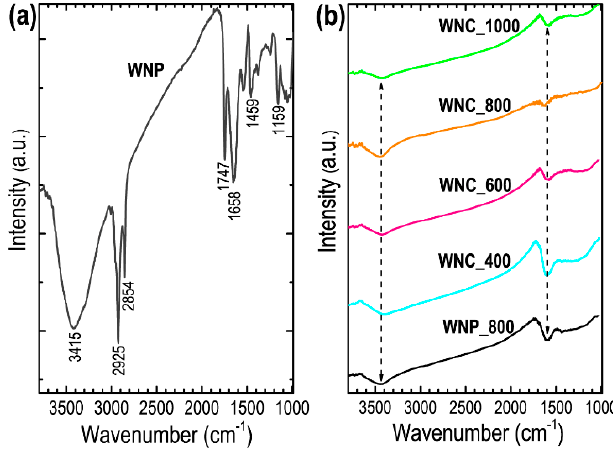
Figure 3. ( a ) FTIR spectrum of Washnut seed powder (WNP) before activation, and ( b ) FTIR spectra of carbonized/activated samples WNP_800, WNC_400, WNC_600, WNC_800, and WNC_1000 measured at 25 °C.